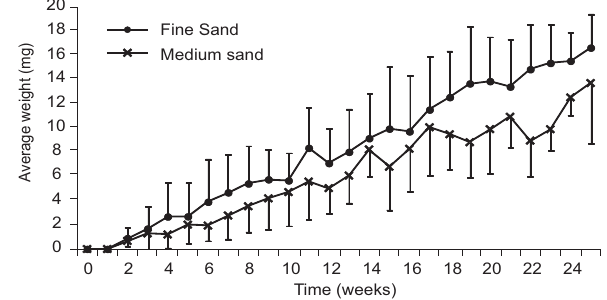
Figure 3. Average weight (± standard deviation) of Limnodrilus hoffmeisteri cultivated in fine sand (0.057-0.250 mm) and medium sand (0.250-1.000 mm) at 25 ± 1°C.